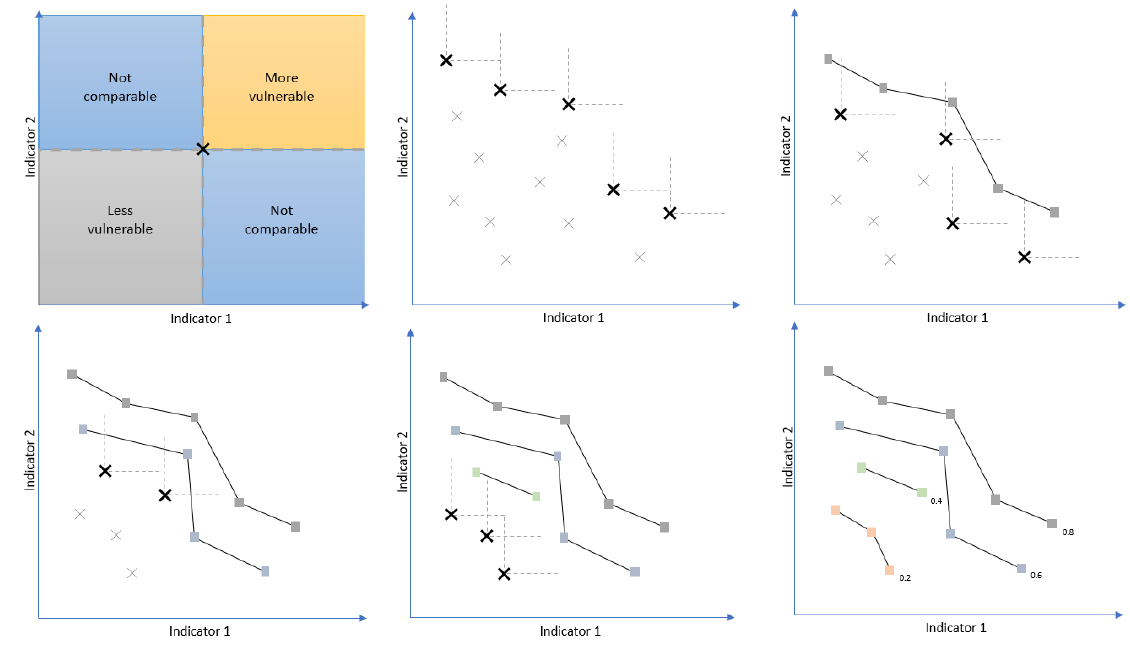
Figure 4. Graphic demonstration of Pareto front classification in two dimensions (two indicators). A non-dominated point is one that has no other points above and to the right of it (i.e., with higher values in both indicators 1 and 2). The same principle applies when scaled to N number of dimensions. Adapted from